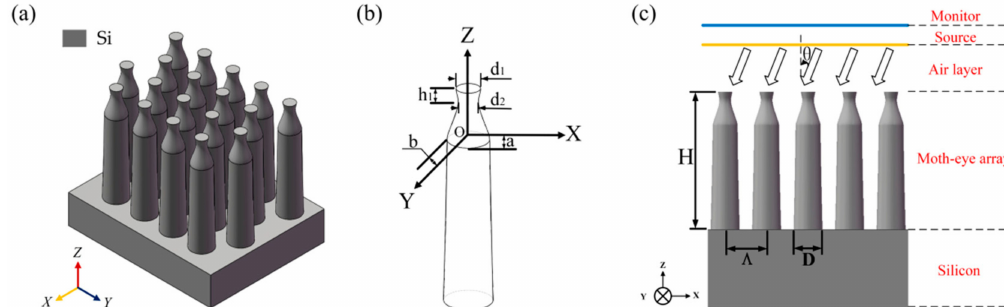
Figure 1. Model of the moth-eye structure with the waist: ( a ) three-dimensional (3D) diagram of the simulated model; ( b ) 3D diagram of the designed coordinate parameters of the moth-eye structure unit; ( c ) schematic diagram of the simulation